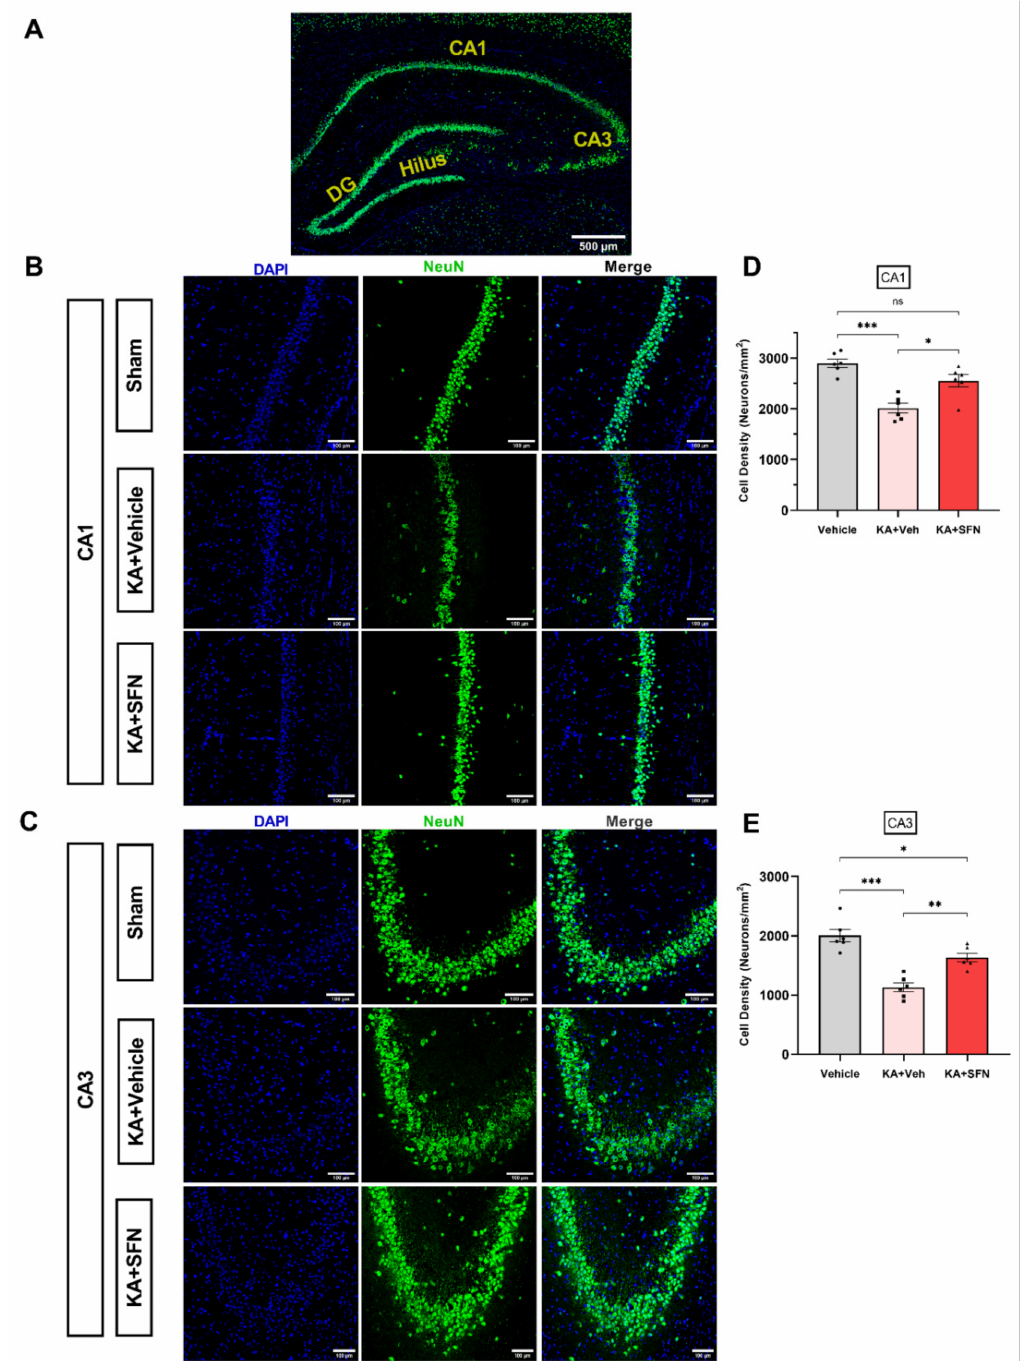
Figure 5. SFN prevents neuronal cell loss in the hippocampus following SE in vivo. ( A ). Analysed Regions of Interest (ROI) for CA1 and CA3 in the hippocampus. ( B , C ). Representative images of the CA1 and CA3 fields of the hippocampus of sham (vehicle-treated) controls ( n = 6) and of rats treated with either SFN (5 mg/kg/day over 5 days, n = 6) or vehicle (equal volume and number of injections as SFN group, n = 6), 7 days following KA-SE onset. DAPI (Blue), and NeuN (Green) labelling, top to bottom. Scale = 500 µ m in ( A ) and 100 µ m in ( B , C ). ( D , E ). Cell densities in the CA1 and CA3 fields of animals in B and C, respectively. Data are expressed as the mean ± SEM. * p < 0.05, ** p <0.01, and *** p < 0.001 compared to sham group by one-way ANOVA followed by Tukey’s post hoc test. [( D ): F (2, 15) = 19, p < 0.0001; ( E ): F (2, 15) = 26, p <